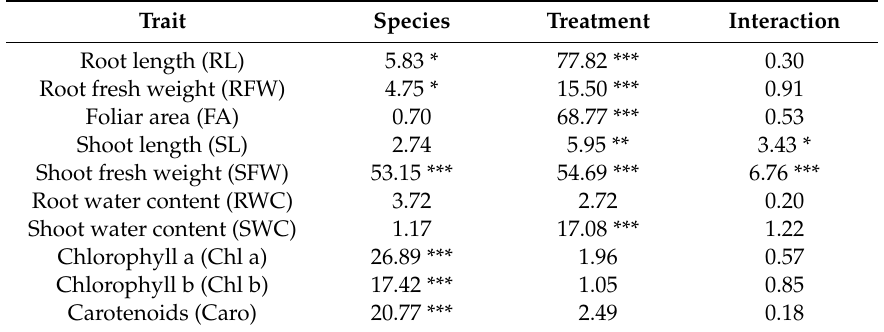
Table 2. Two-way analysis of variance (ANOVA). E ff ects of species, treatment and their interactions, on the analyzed parameters. Trait Species Treatment Interaction Root length (RL) 5.83 * 77.82 *** 0.30 Root fresh weight (RFW) 4.75